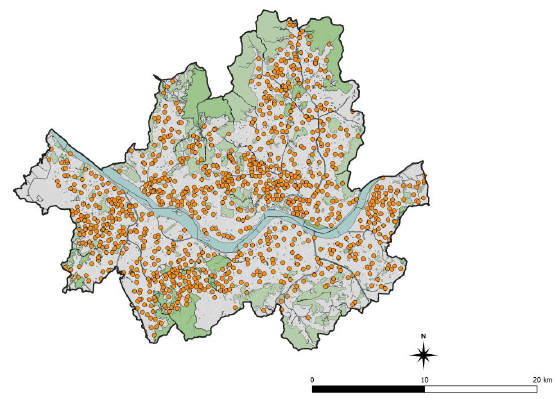
Figure 2. Distribution plot of Smart-Seoul Data of Things (S-DoT).